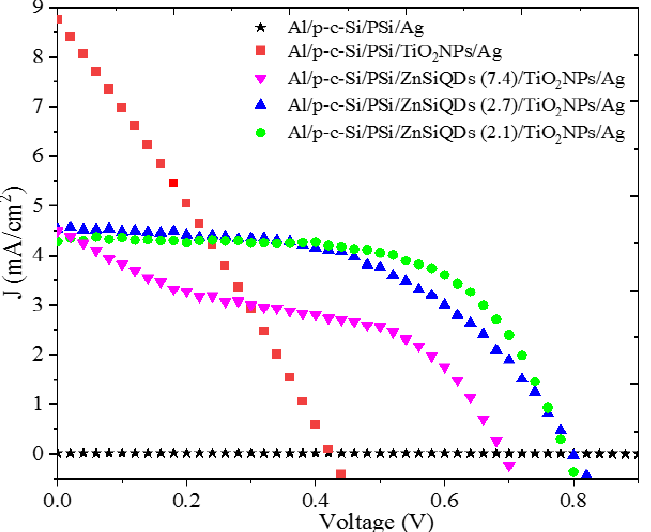
Figure 7. Photovoltaic performance comparison of the cells made of Al/p-c-Si/PSi/Ag, Al/p-c-Si/PSi/ TiO 2 NPs/Ag, Al/p-c-Si/PSi/ZnSiQDs/TiO 2 NPs/Ag (ZnSiQDs mean size of 7.4 nm), Al/p-c-Si/PSi/ZnSiQDs/TiO 2 NPs/Ag (QDs mean size of 2.7 nm) and Al/p-c-Si/PSi/ZnSiQDs/TiO 2 NPs/Ag (QDs mean size of 2.1 nm).